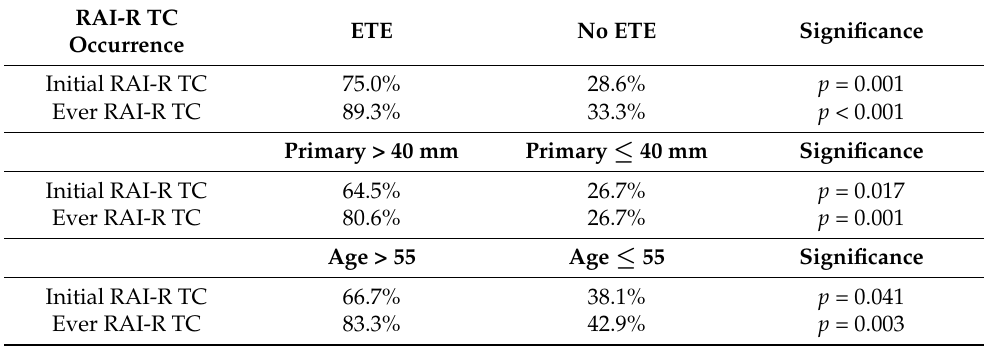
Table 3. Risk factors for radioiodine refractory disease at initial diagnosis and in the course of disease. RAI-R